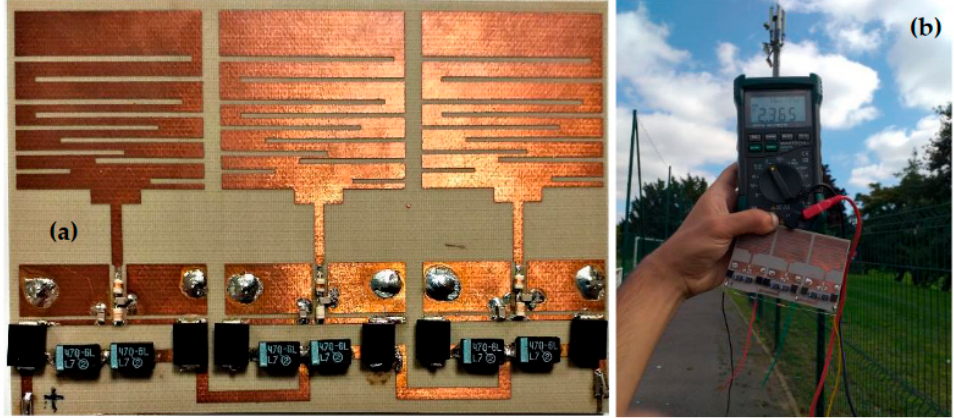
Figure 17. ( a ) Realized RF-EH1 based on the first architecture, ( b ) Measurement prototype at 22 m from relay antenna .